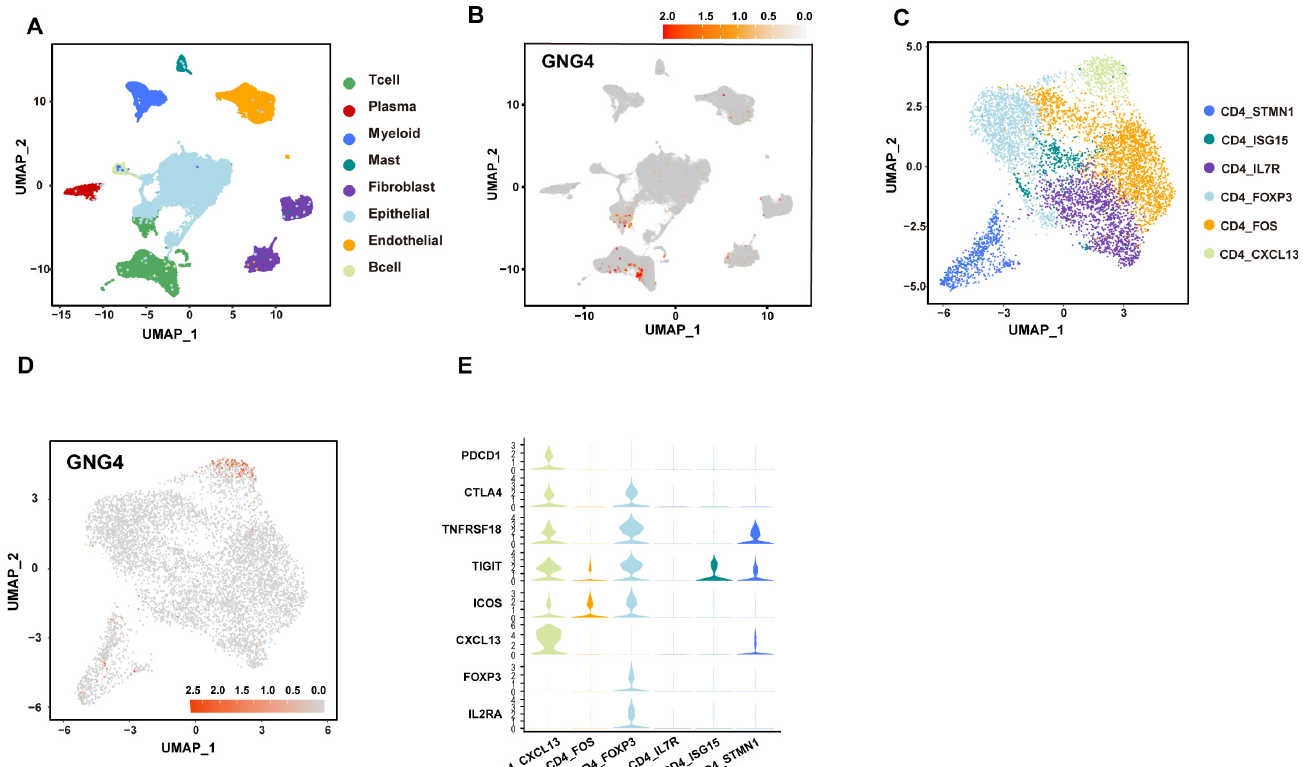
Figure 1. GNG4 is a biomarker for exhausted CD4 + T cells population in BLCA. ( A ). The UMAP plot of all cells. Each dot indicates a single cell. Color-coded for the cell type. ( B ). The UMAP plot of GNG4 expression. ( C ). UMAP plot of CD4 + T cells. Each dot indicates a single cell, and colors refer to clusters denoted by CD4 + T cell types. ( D ). The expression of GNG4 in each type of CD4 + T cells. ( E ). Dot plot of immune-related genes expressed in types of CD4 + T cells.